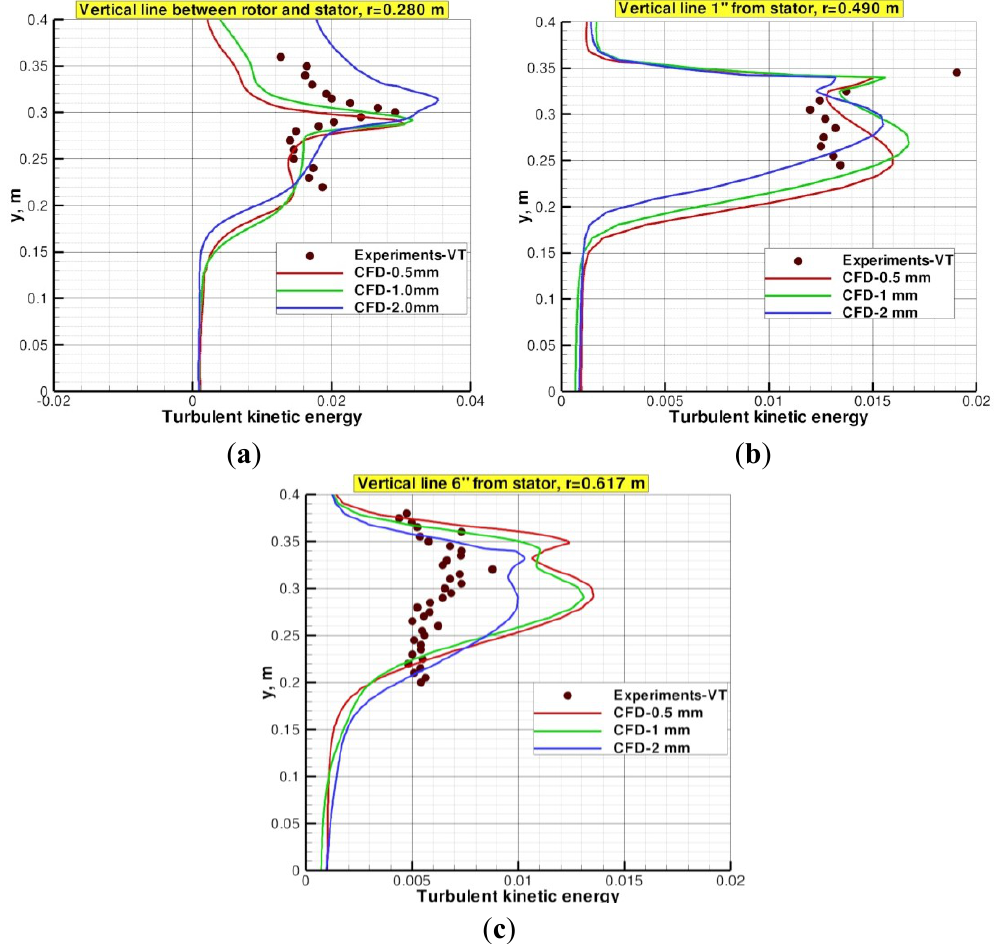
Figure 10. ( a ) Normalized TKE on a vertical line r = 0.28 m in the gap between the rotor and the stator; ( b ) normalized TKE along vertical line at 25.5 mm from the stator ring in the radial direction; and ( c ) normalized TKE on a vertical line 152.4 mm from the stator ring in the radial direction.